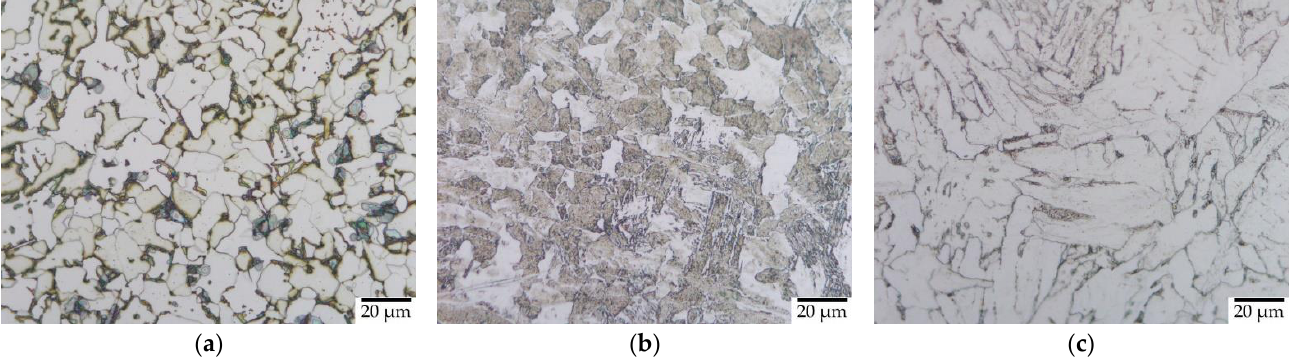
Figure 4. Microstructure of ( a ) original (O), ( b ) quenched (Q), and ( c ) tempered (T) samples by HT1.